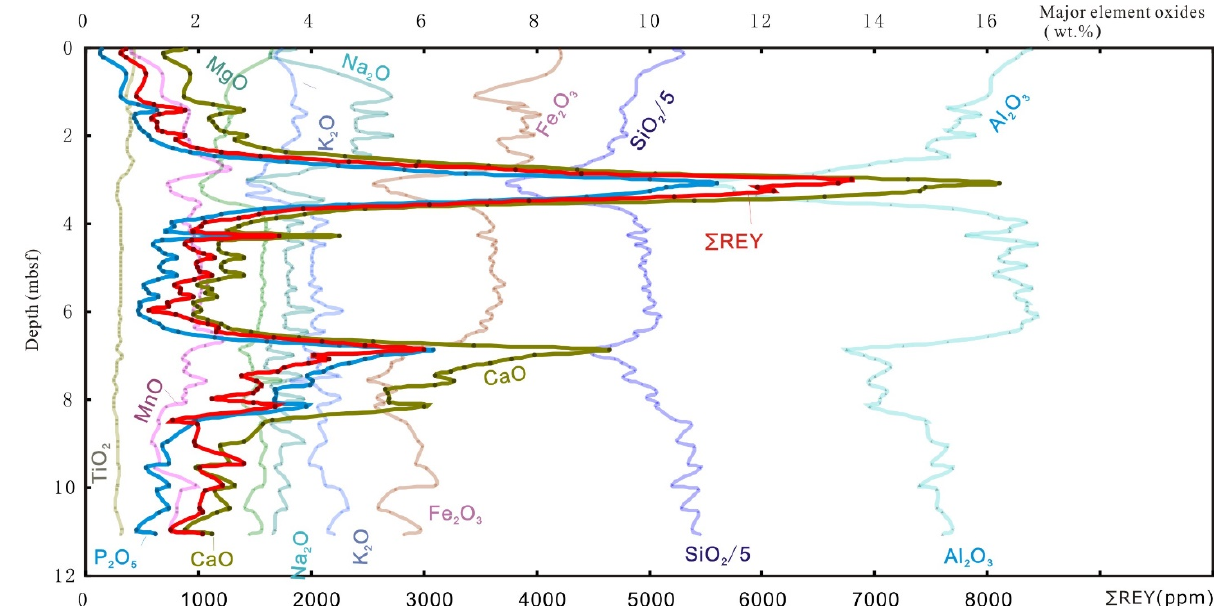
Figure 4. Relationship between the Σ REY and the major oxides of samples at each layer at site KR13 ‐ 02 PC05; data are from [9]. The units for ∑ REY are ppm; the units for oxides are weight percentage. The curves of Σ REY, CaO, and P 2 O 5 content are highly variable, showing obvious positive correlations.